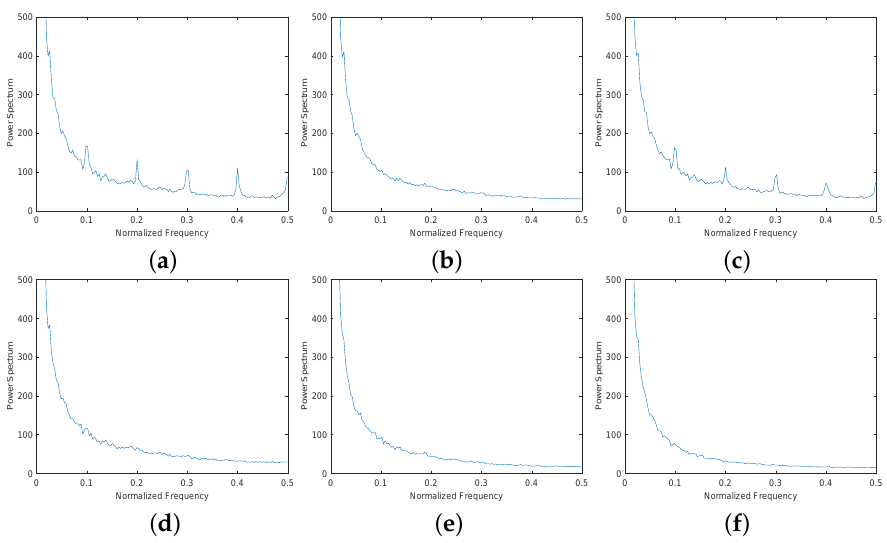
Figure 17. Pow spectrums of Figure 12. ( a ) Original image; ( b ) WAFT; ( c ) SLD; ( d ) GSLV; ( e ) LRSID; ( f ) the proposed method.